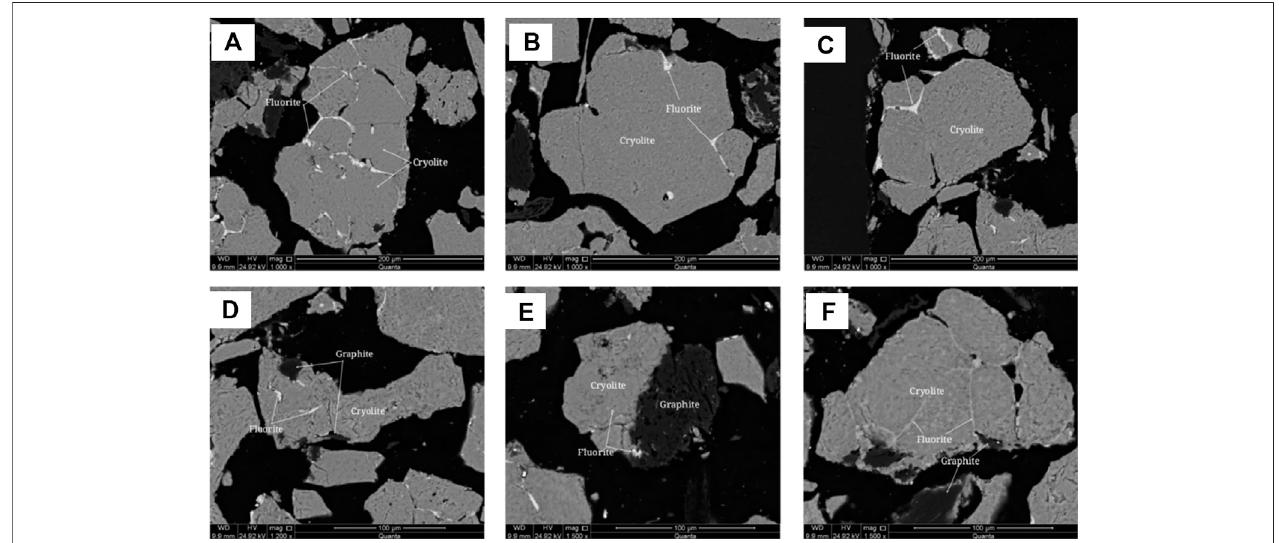
FIGURE 8 | Scanning electron microscope backscattered electron image of cryolite. (A) Fluorite fi lling between cryolite grains; (B) Fluorite fi lling between cryolite grains; (C) Fluorite fi lling between cryolite grains; (D) anisotropic granular cryolite particles encapsulate fi ne fl uorite; (E) Fine-grained fl uorite encapsulated in cryolite; (F) Fluorite fi lling between cryolite grains.